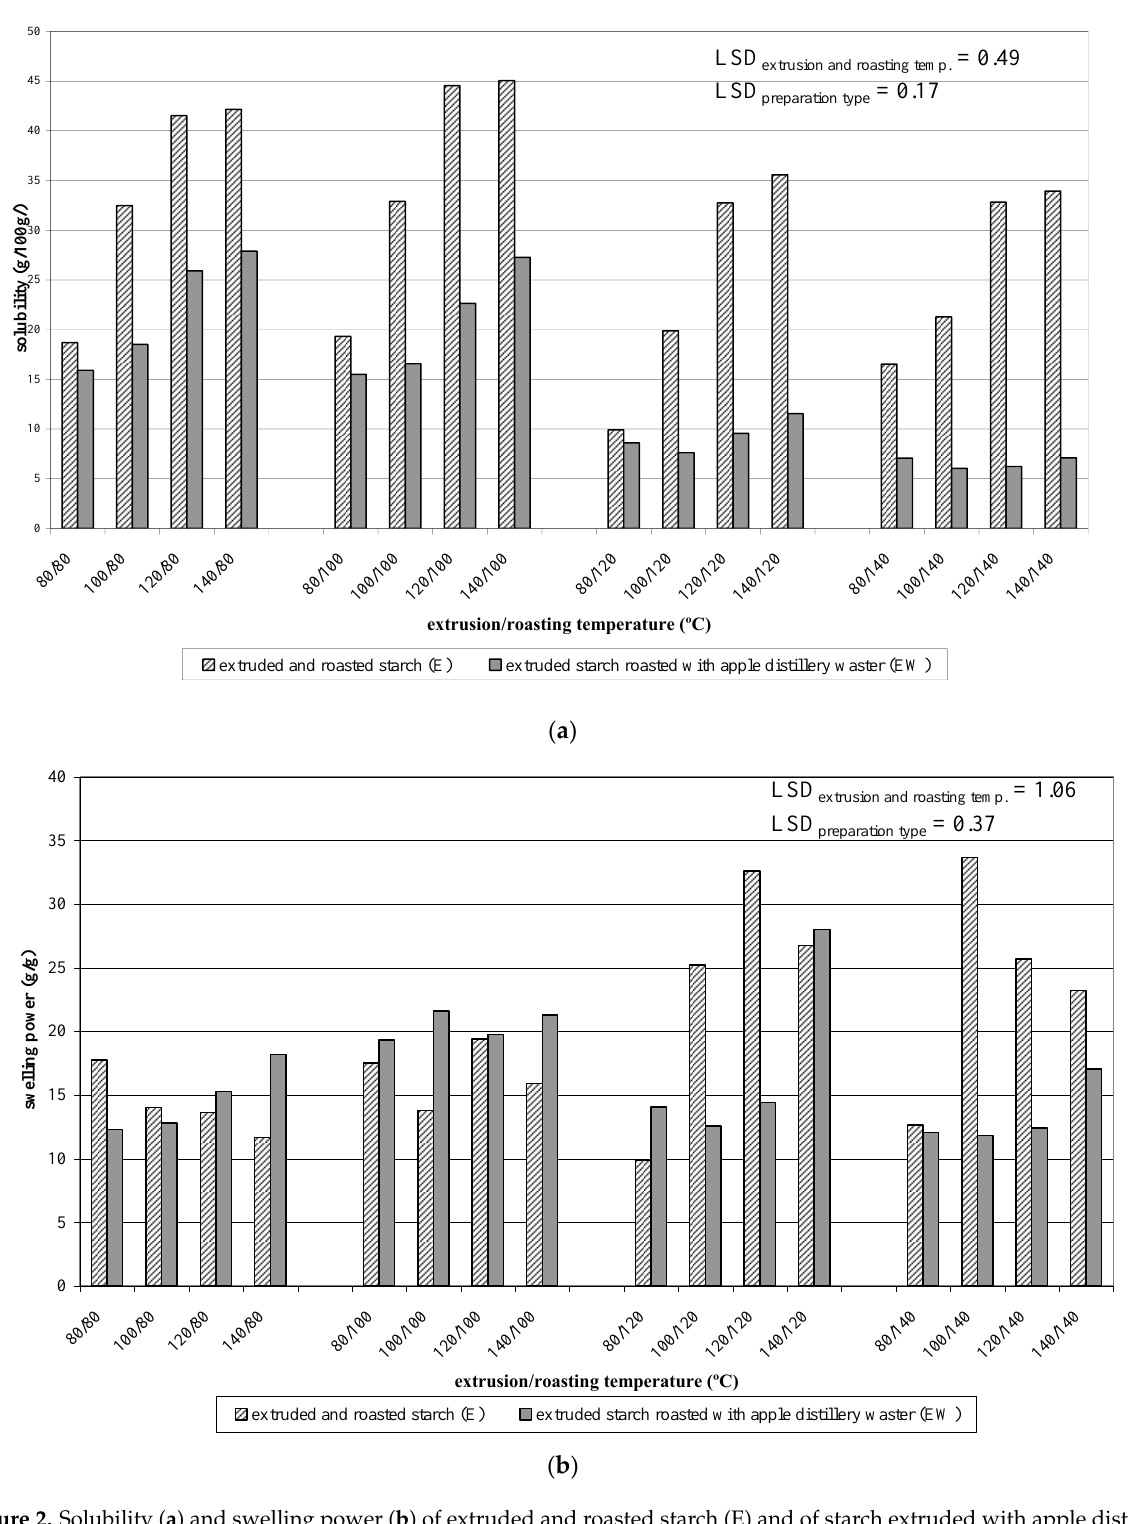
Figure 2. Solubility ( a ) and swelling power ( b ) of extruded and roasted starch (E) and of starch extruded with apple distiller wastewater and roasted (EW).